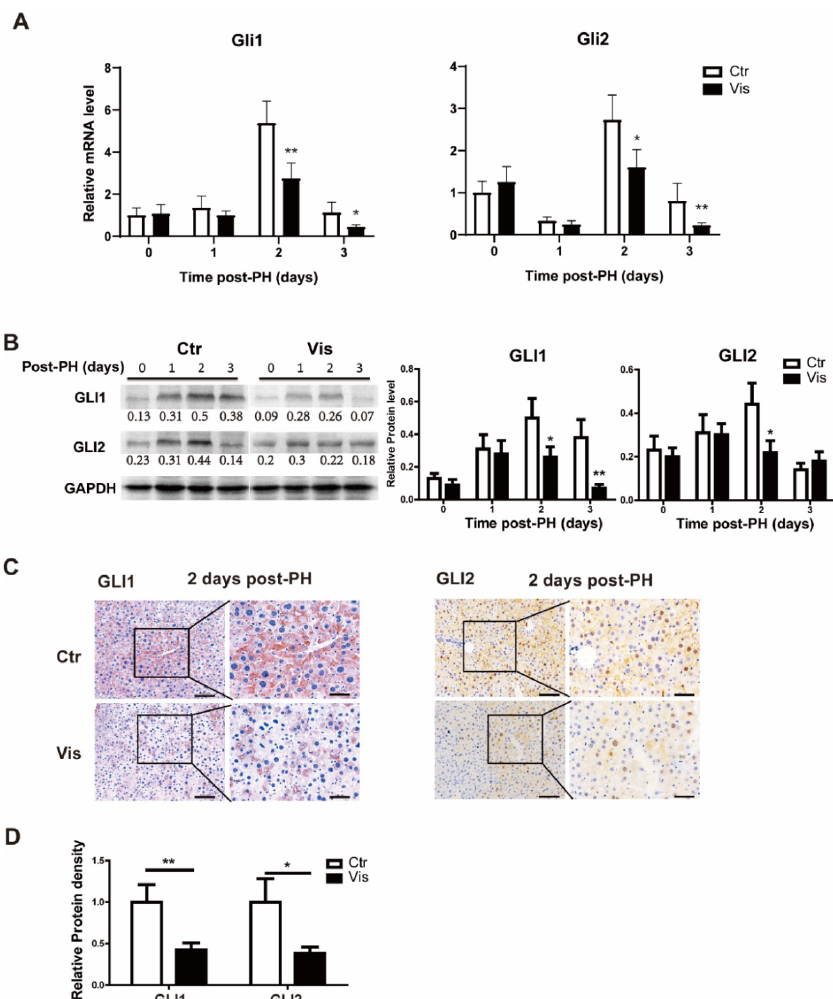
Figure 3. Vismodegib inhibits the activation of the Hh pathway after PH. ( A ) QRT-PCR analysis of Hh signaling pathway intracellular signaling molecules GLI1 and GLI2 in liver tissue at different times after PH (0, 1, 2 and 3 days), n = 5. ( B ) Representative Western blot analysis of GLI1 and GLI2 in the liver tissue between the two groups at different times after PH (0, 1, 2 and 3 days). Western blot quantification analysis compared to GAPDH is shown under the bands. ( C ) Representative immunohistochemical pictures of GLI1 and GLI2 in the liver slices of mice at two days after PH between the two groups. ( D ) Results of GLI1 and GLI2 immunohistochemical quantitative analysis of the two groups at 2 days post-PH are shown in the histogram, analyzed with Image J, 5 pictures for each group, n = 3. All data represent means ± SEM. * p < 0.05, ** p < 0.01 vs. control